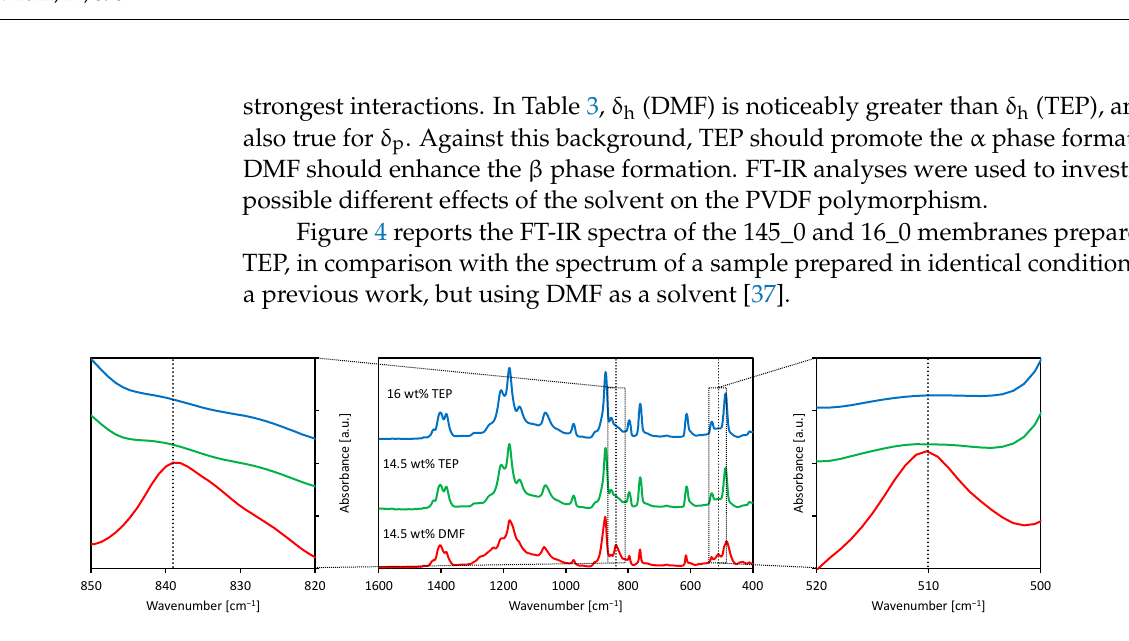
Figure 4. FT-IR spectra of the 16 wt % PVDF (blue) and 14.5 wt % PVDF (green) samples (this work) compared with a 14.5 wt % PVDF membrane prepared using DMF as solvent (red).